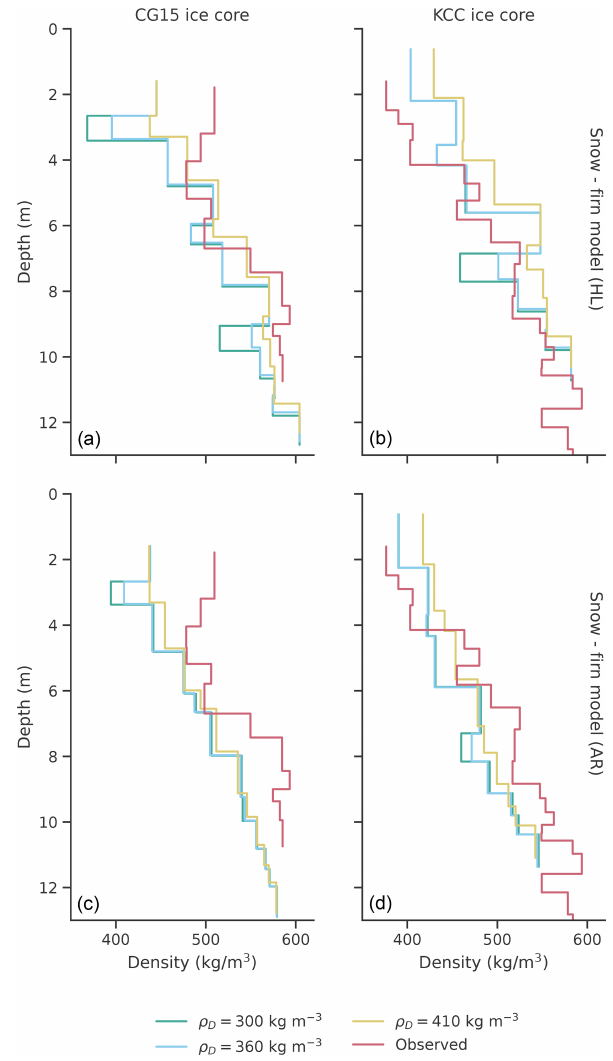
Figure 8. Observed and modelled (with multi-layer version) firn density profiles for KCC (b, d) and CG15 (a, c) . AR and HL stand for the model versions with Arnaud et al. (2000) and Herron and Langway (1980) implemented,